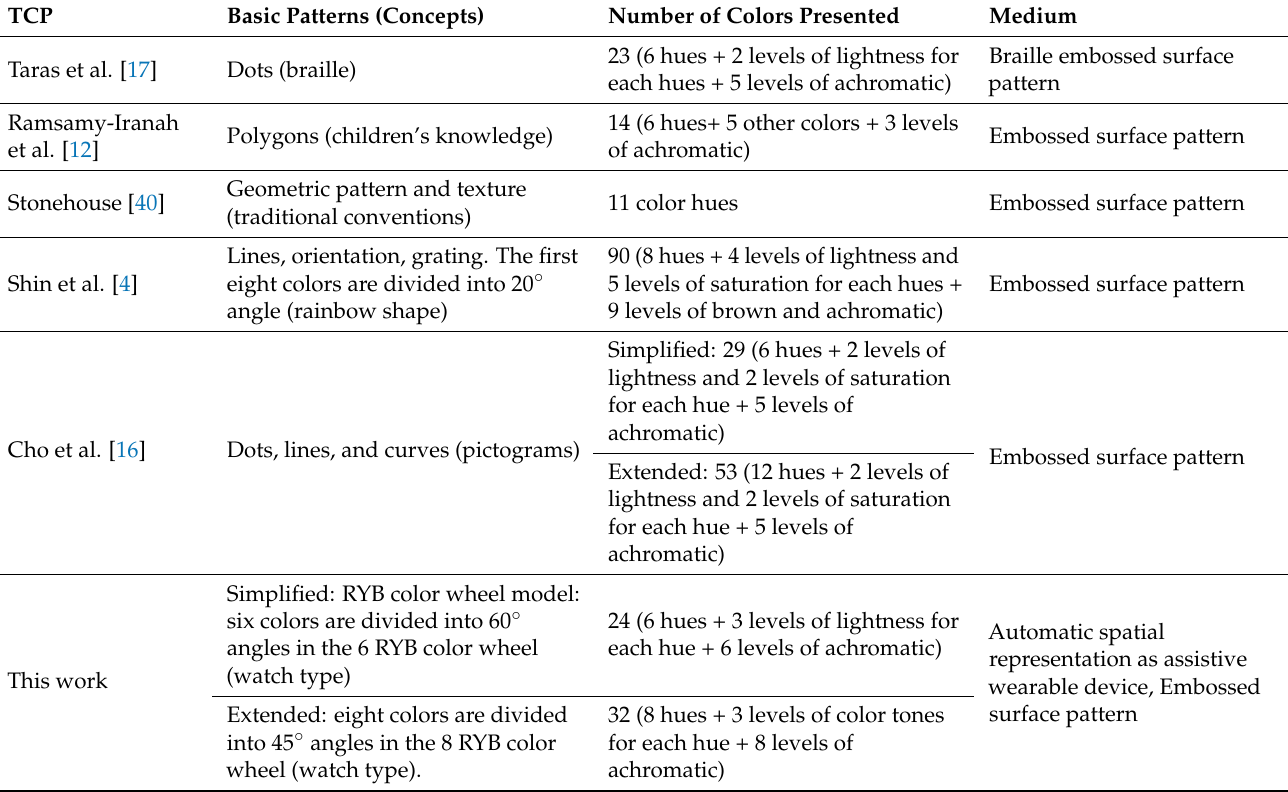
Table 7. The overview and comparison with relevant works on tactile color